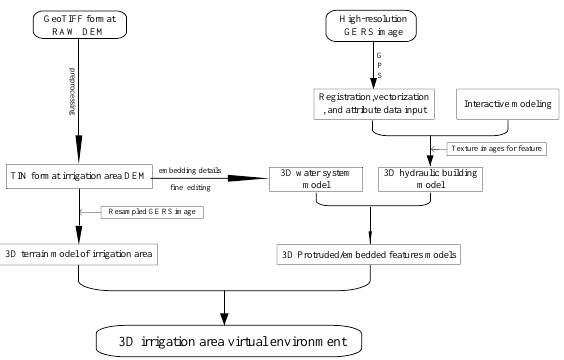
Fig.3 Flowchart for creating a 3D virtual environment of irrigation area